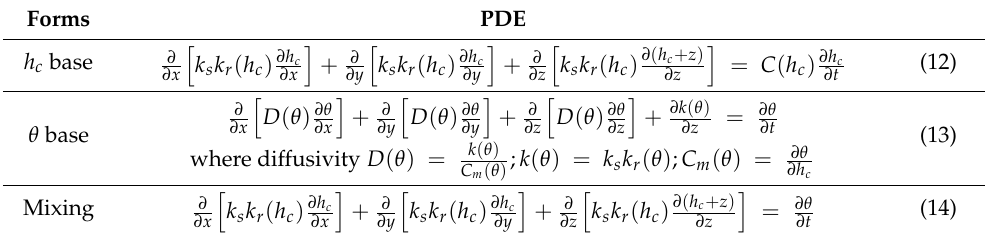
Table 2. Richards model forms on different state variable basis